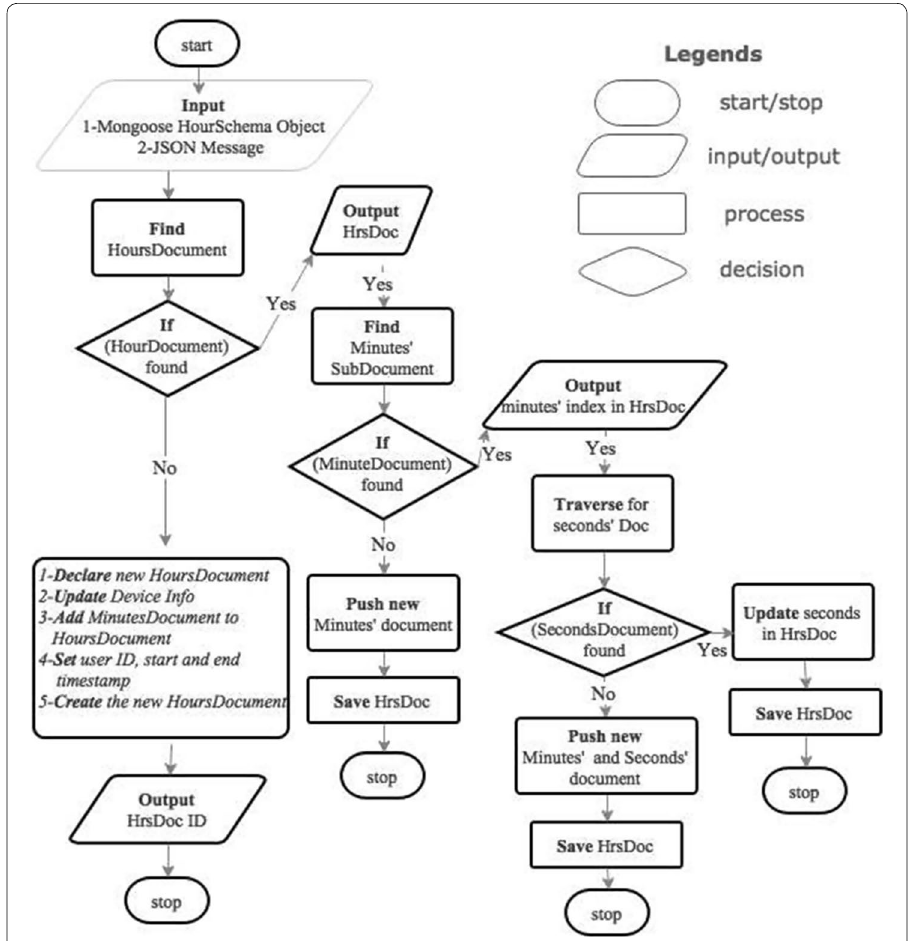
Fig. 8 The flowchart of the Mongoose based schema evolver